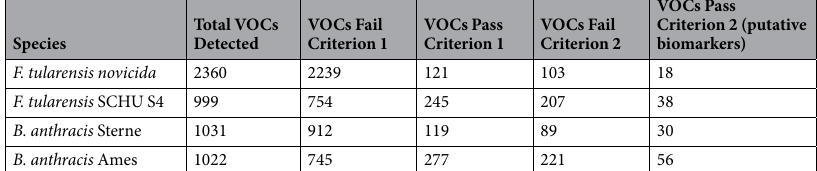
Table 1. Number of VOCs from F. tularensis and B. anthracis taxa detected by GC-MS and remaining after application of filtering